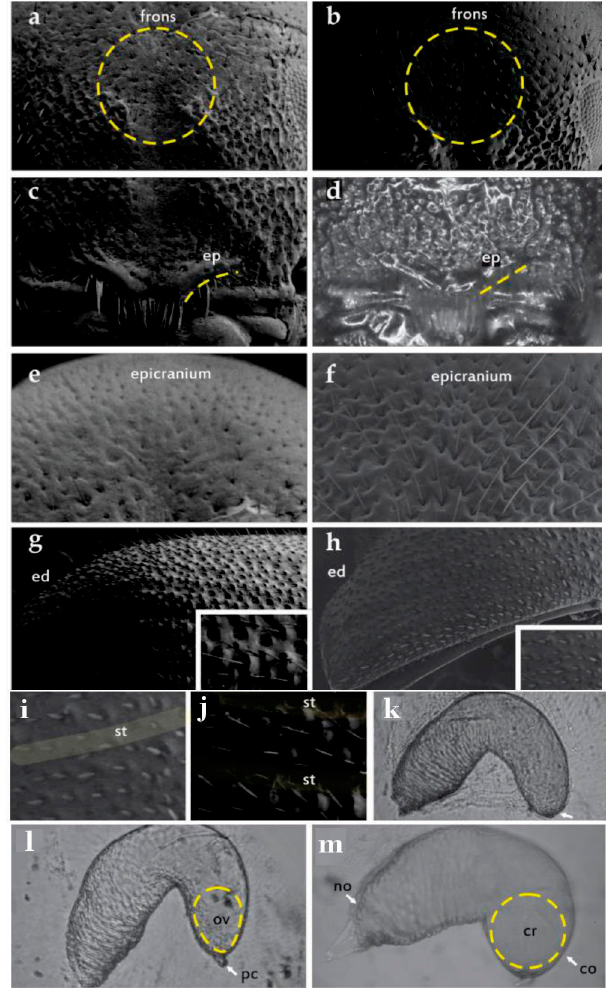
Figure 2. Qualitative characters evaluated in D . brevicomis populations: FS —Frontal sculpture ( a , b ); DE — Degree of elevation in the epistomal process, ep ( c , d ); ES —Epicranium surface ( e , f ); SPD —Size of the pubescences in the elytral declivity, ( g , h ); RSP —Thickness of the pubescences of the striae in relation to the pubescences of the interestriae ( g , h ); SED —Striae on the elytral declivity, st ( i , j );